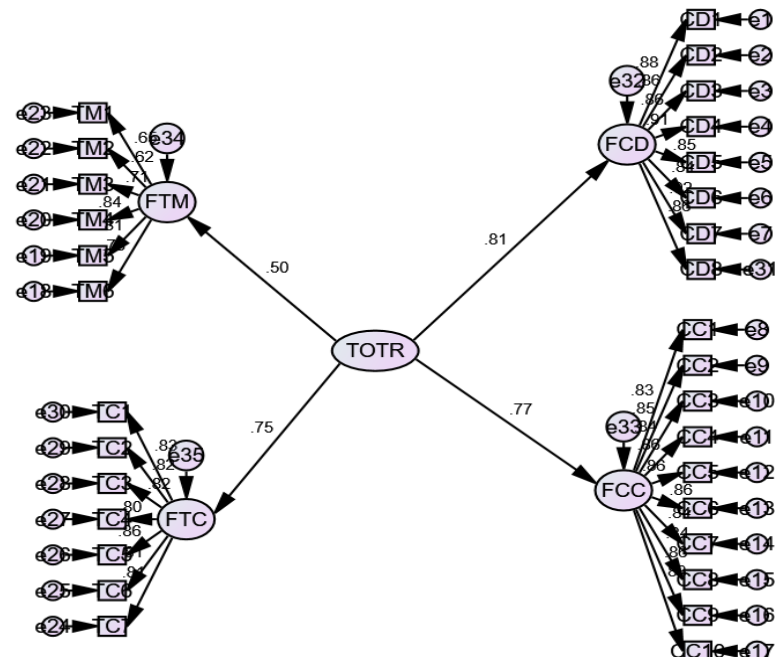
Figure 5. Second-order measurement model for teacher-level constructs. The results met the criteria for convergent (Table 3) and discriminant validities (Table 4). Both measurement models had better fit indices (Table 2). The values of Cronbach’s Alpha ( α ) and composite reliability for the first and second-order constructs were also greater than 0.70 and 0.80, respectively, showing good reliability Table 3. Second-order measurement model results (Level-2).